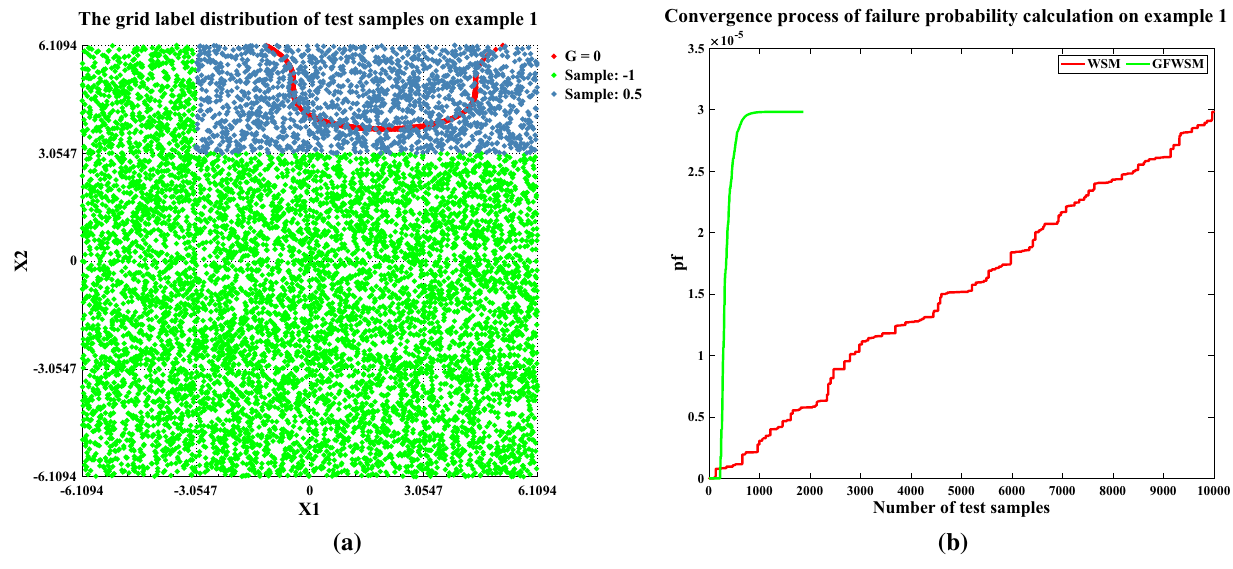
Fig. 4 Simulation results on reliability analysis example 1: a the grid label distribution of test samples in GFWSM, b convergence process of failure probability of WSM and GFWSM Table 1 Time complexity of the GFWSM-DMOEOA algorithm Step Time complexity Position updating O ( KN ) Grid mechanism O ( KN 2 ) Layered disruption